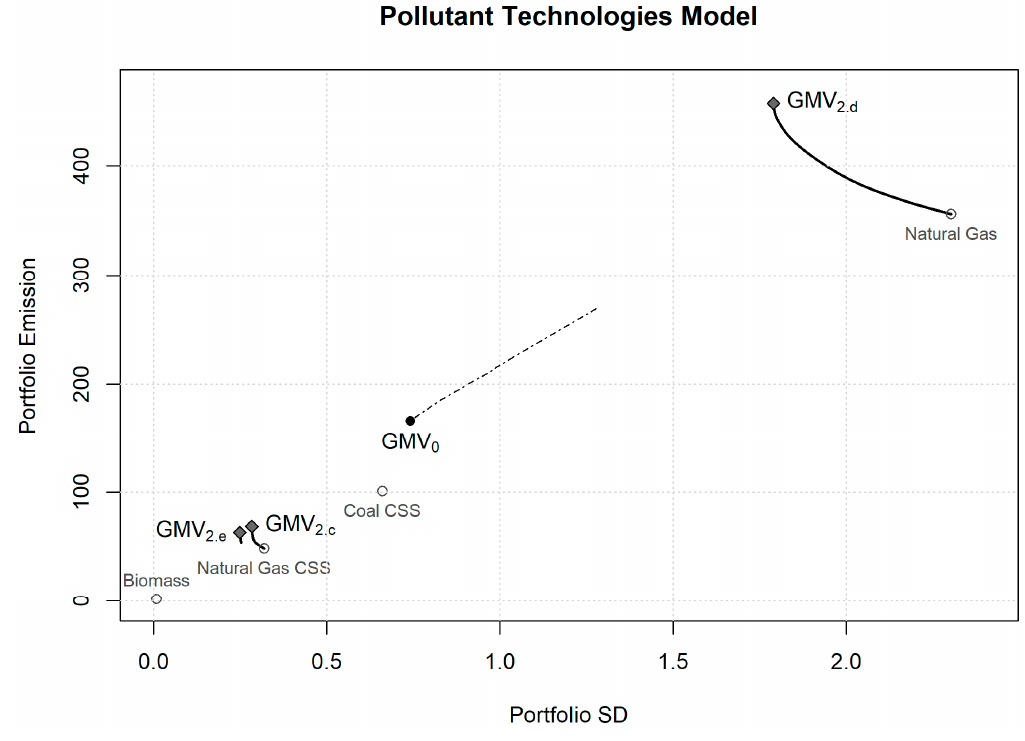
Figure 7. E ffi cient frontiers in an emission-risk Figure 7. Efficient frontiers in an emission-risk plane.